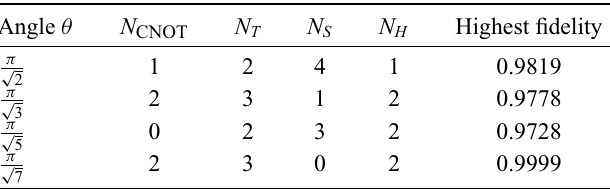
TABLE VI. The number of gates: the results of searching for CR -gate decompositions for four different angles— —obtained with the help of exhaustive search (up to ten and π √ 7 circuit layers) and stochastic descent (up to 20 circuit layers). The universal gate set is S . We observe here that while for π √ find a suitable decomposition with high fidelity, this is not the case for the remaining angle values. Moreover, two of the best decompositions contain two CNOT gates, which again leads us to a much longer gate-evolution time.